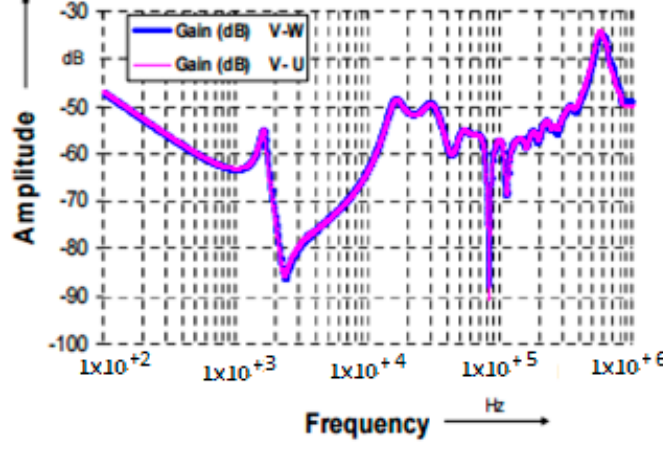
Figure 8. FRA measurement on HV for a normal healthy transformer [21].